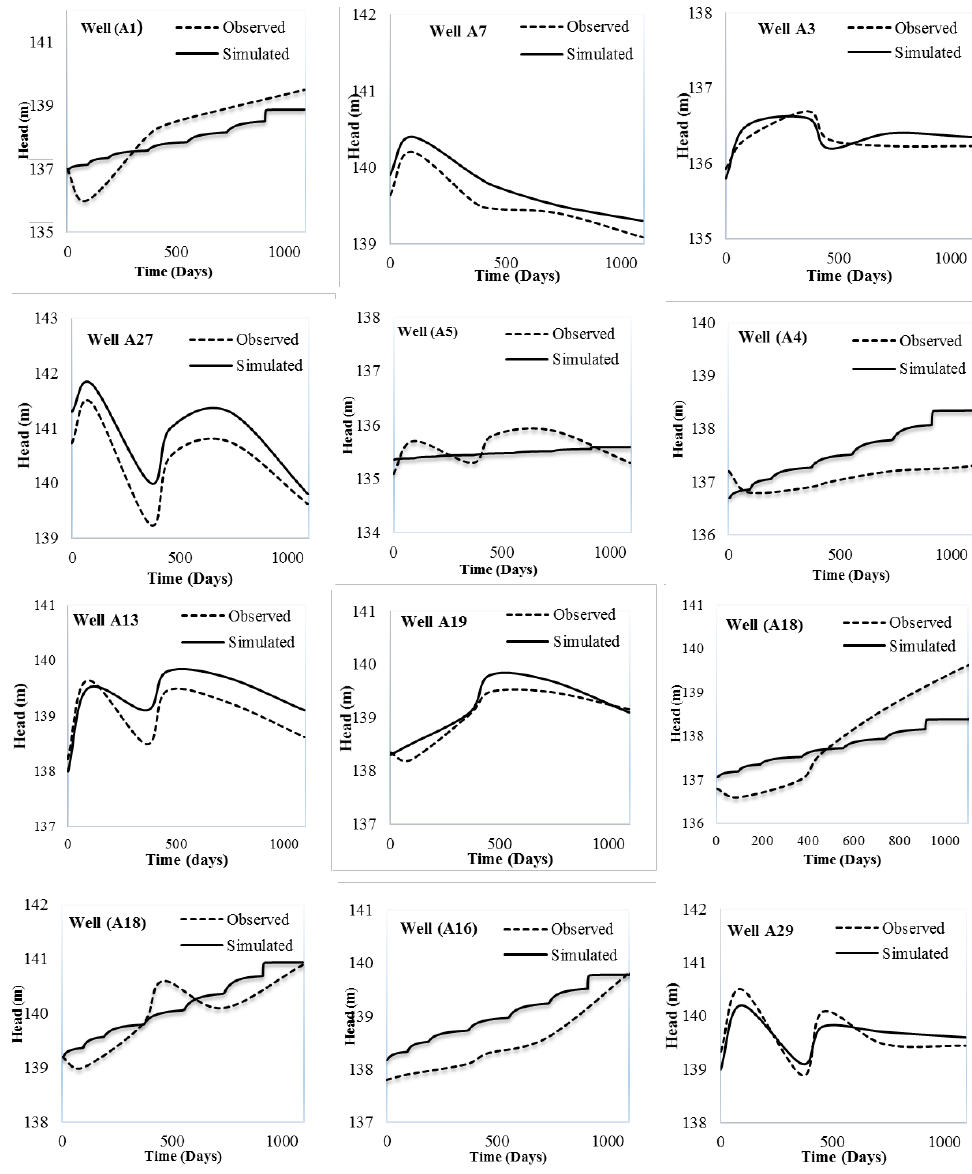
Figure 4. Model Calibration Curves.